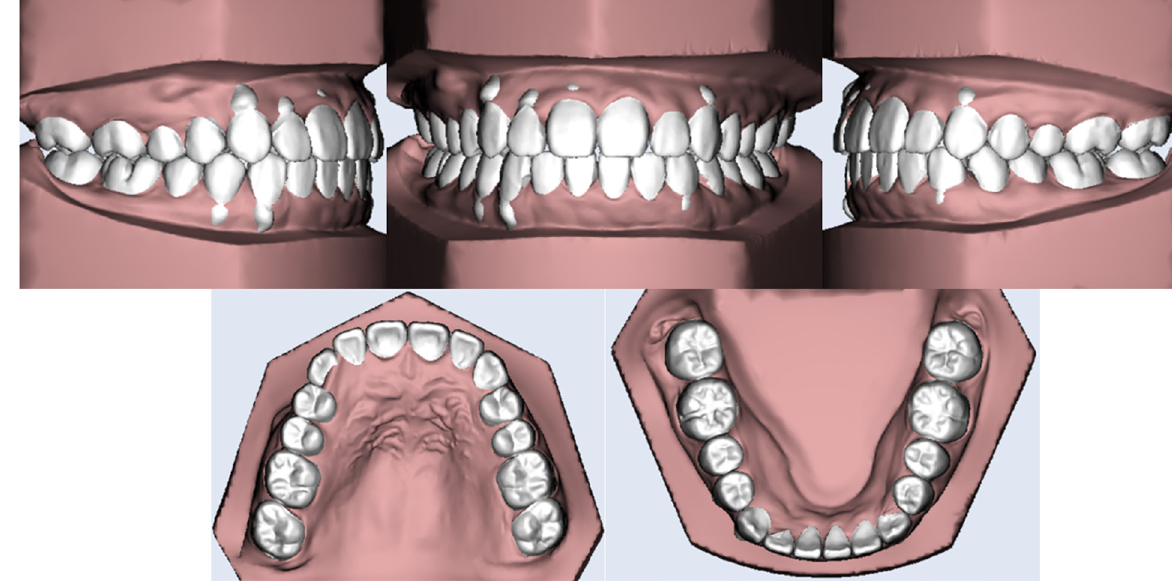
Figure 10. Digital set-up model.